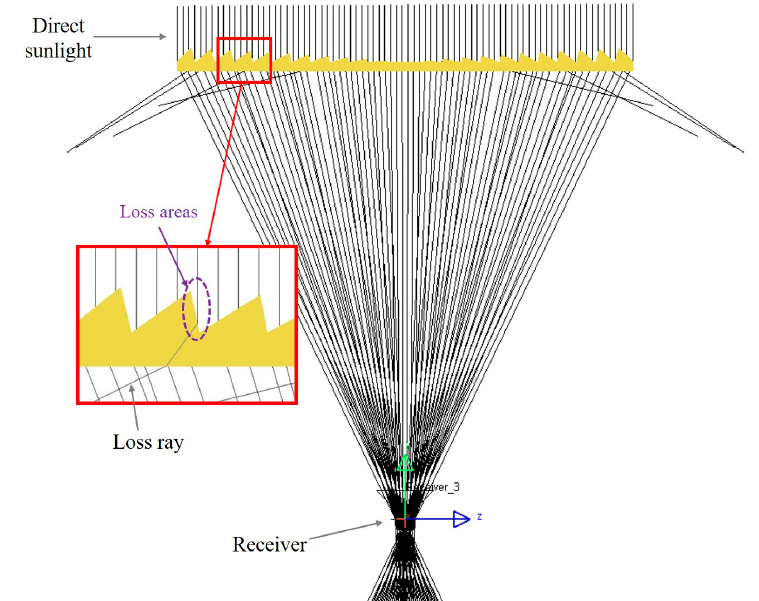
Figure 15. Ray tracing of the upper surface and the loss areas on the upper surface.